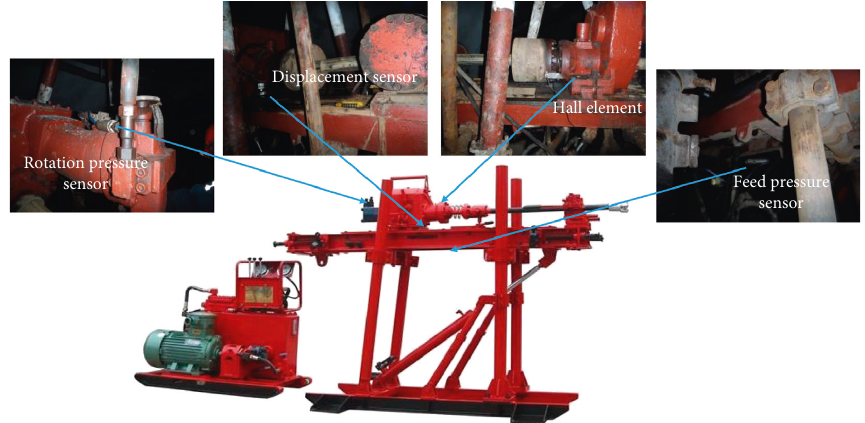
Figure 7: Installation of the sensors in MWD system.